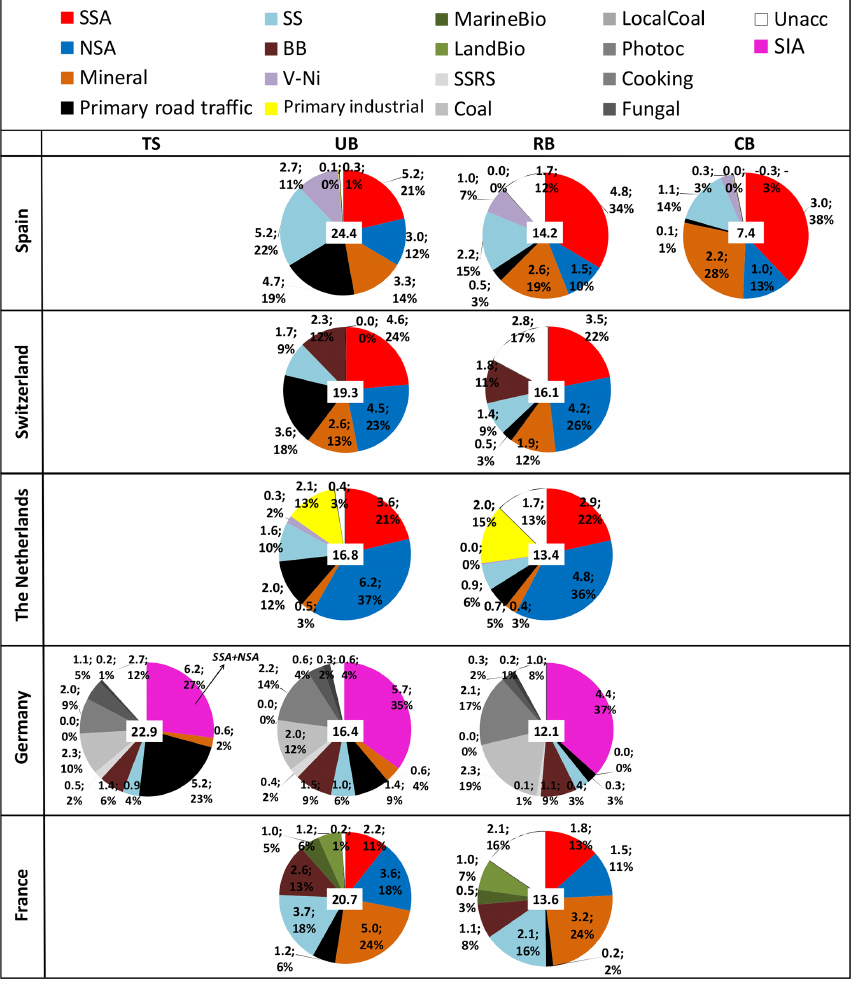
Figure 2. Mean annual source contributions to PM 10 (PM 2 . 5 for NL) from the multisite PMF for each country. The number in the white box at the centre of the pie chart is the measured mass of PM (µgm − 3 ). TS: traffic site; UB: urban background; RB: regional background; CB: continental